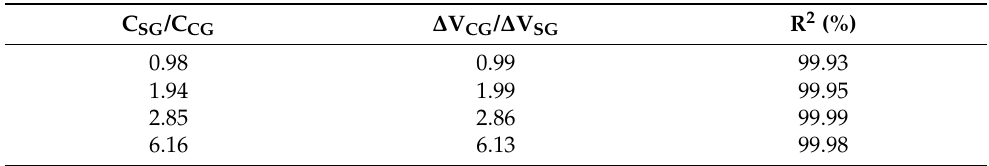
Table 1. Amplification factors ( ∆ V CG / ∆ V SG ) obtained from the DC bias test of the a-IGZO coplanar dual-gate